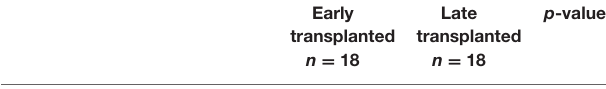
TABLE 1 | Baseline characteristics of the study population.